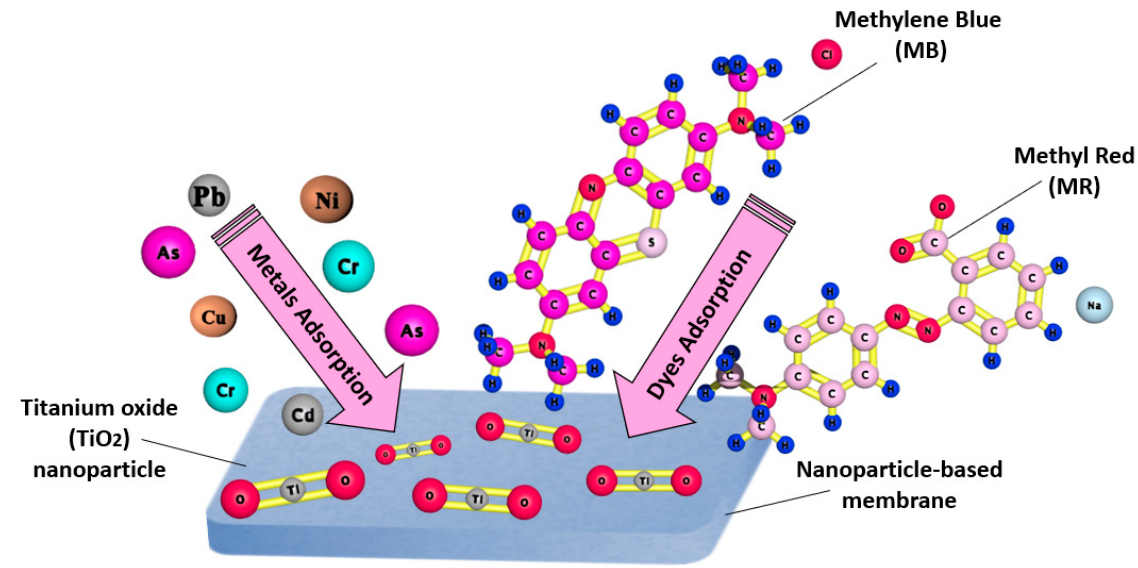
Figure 3. Schematic representation of heavy metals and dye adsorption by a nanoparticle-based membrane for water treatment.